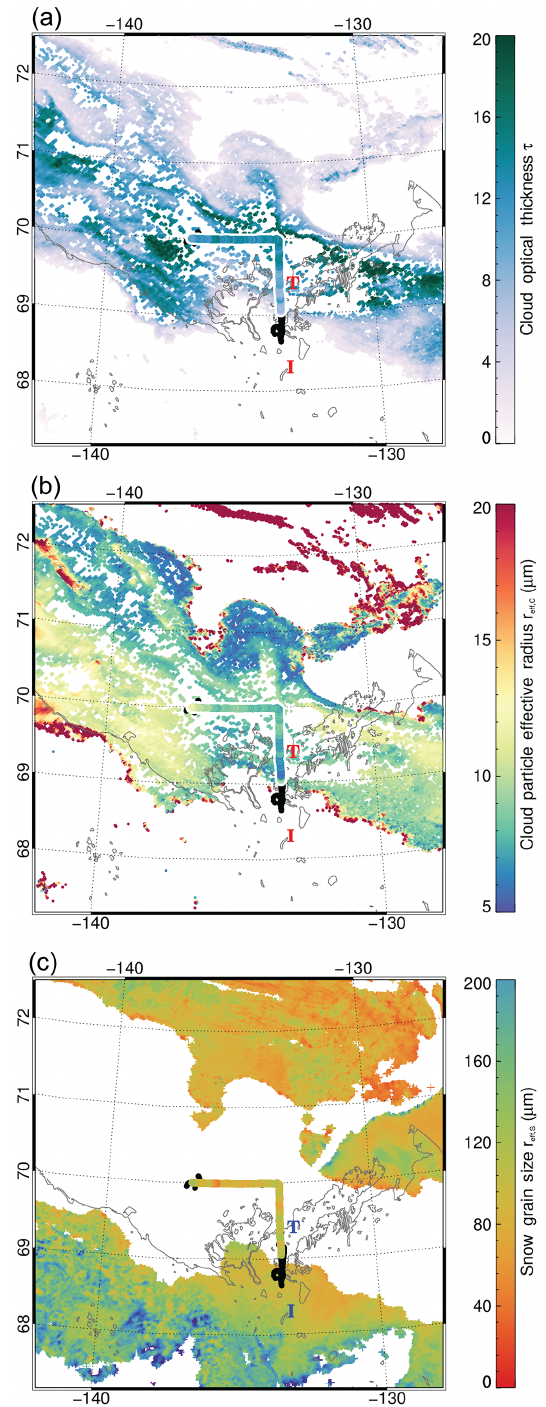
Figure 8. Cloud optical thickness τ (a) , cloud droplet effective ra- dius r eff , C (b) and effective snow grain size r eff , S (c) retrieved by MODIS and SMART for Case I on 29 April 2012. The total flight track is indicated by a black line and overlayed by the retrieval re- sults of SMART. “I” and “T” mark the locations of Inuvik and Tuk-